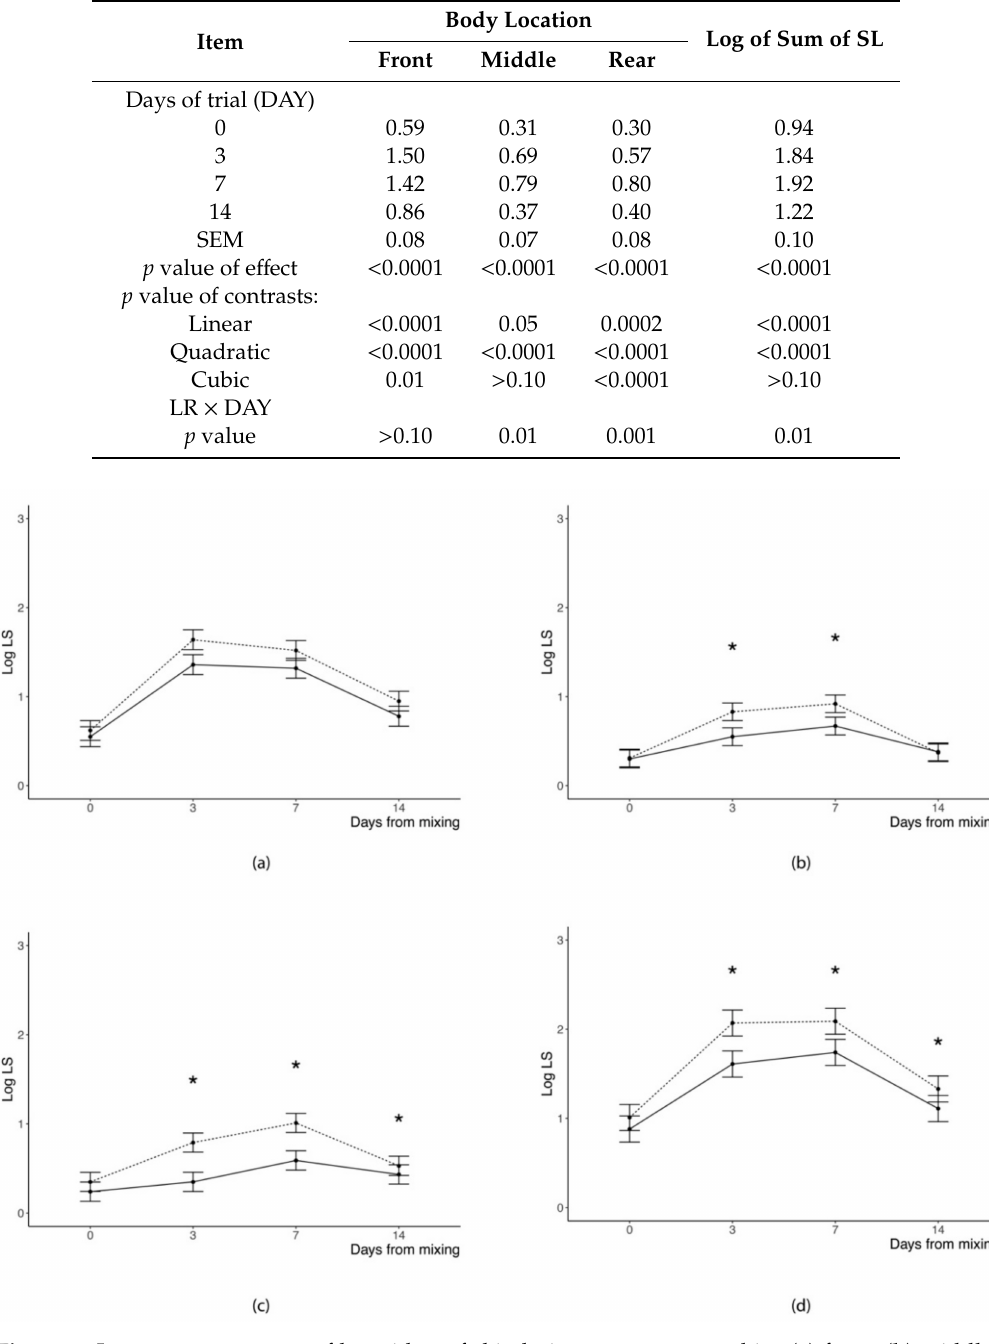
Figure 2. Least squares means of logarithm of skin lesions count assessed in: ( a ) front, ( b ) middle, and ( c ) rear position and of ( d ) logarithm of sum of counts at di ff erent days from mixing (Days Mix) for pigs kept in dark rooms (solid line) or with a 12 h photoperiod (dotted line) during the first 48 h after mixing (* p < 0.05 for di ff erence between means of the two groups within any given day from